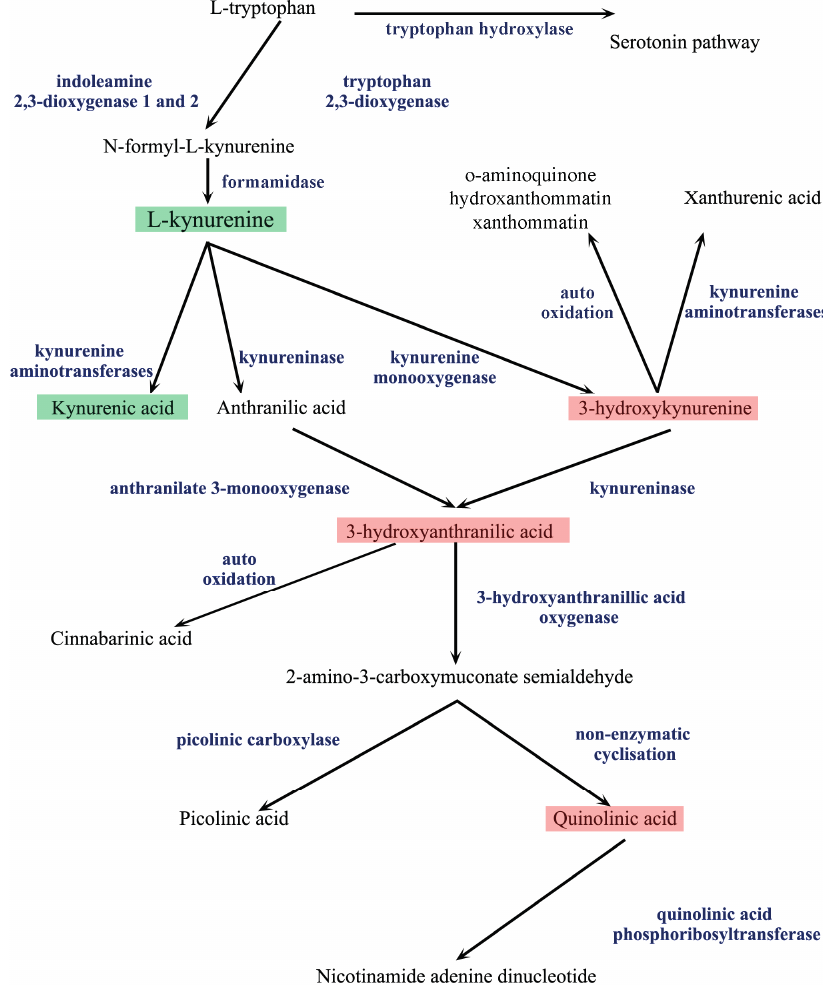
Figure 2. The kynurenine pathway. The metabolism of L -tryptophan is divided into two distinct pathways, the serotonin and the kynurenine pathway (KP). Indoleamine 2,3-dioxygenase 1 and 2 and tryptophan 2,3-dioxygenase convert L -tryptophan to N -formyl- L -kynurenine in the first step of the KP. N -formyl- L -kynurenine is further processed by formamidase to L -kynurenine ( L -KYN), the central metabolite of the KP. From L -KYN, three different enzymes produce the next metabolites, forming three branches of the metabolism. The first branch is the kynurenic acid branch, where kynurenine aminotransferases (KATs) produce kynurenic acid from L -KYN. On the second branch, kynureninase converts L -KYN to anthranilic acid, which is further metabolized by anthranilate 3-monoxygenase to 3-hydroxyanthranilic acid (3-HA). On the third branch, kynurenine monooxygenase produces 3-hydroxykynurenine (3-HK), which is further metabolized by kynureninase to 3-HA. 3-HK can be also metabolized by KATs to form xanthurenic acid or be auto-oxidized. 3-HA is converted by 3-hydroxyanthranilic acid oxygenase to 2-amino-3-carboxymuconate semialdehyde or suffers auto-oxidation to form cinnabarinic acid. 2-amino-3-carboxymuconate semialdehyde can be converted by picolinic carboxylase to picolinic acid or can be converted by non-enzymatic cyclisation to quinolinic acid, which, through conversion by quinolinic acid phosphoribosyltransferase, results in the formation of nicotinamide adenine